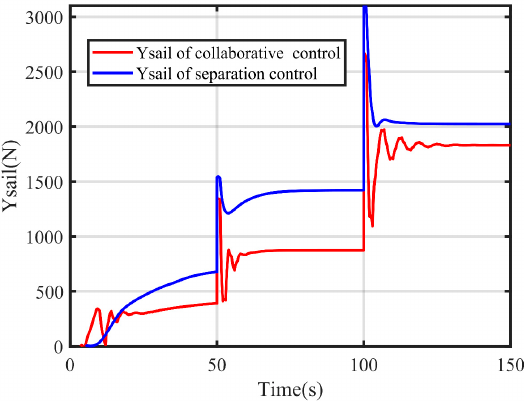
Figure 9. Comparison curves of Ysail for sidewind sailing.